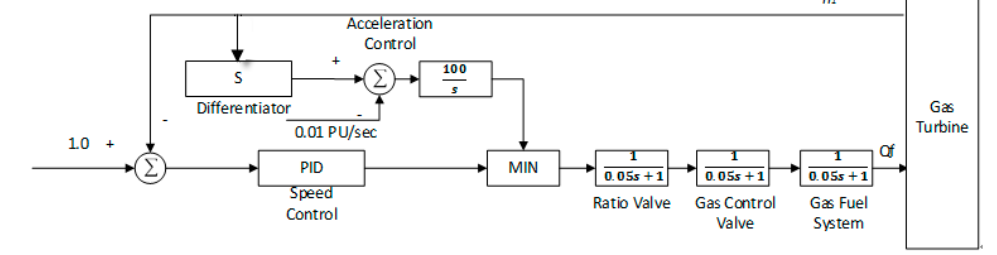
Figure 3. Block diagram for the speed control.